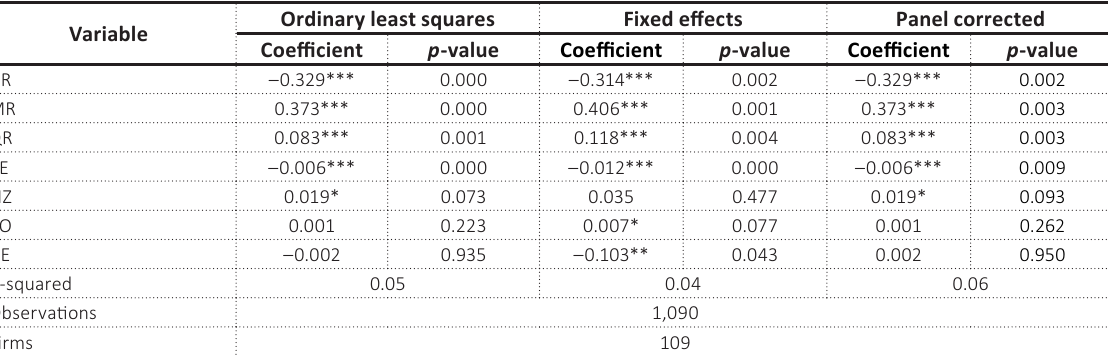
Table 5. Results for equation